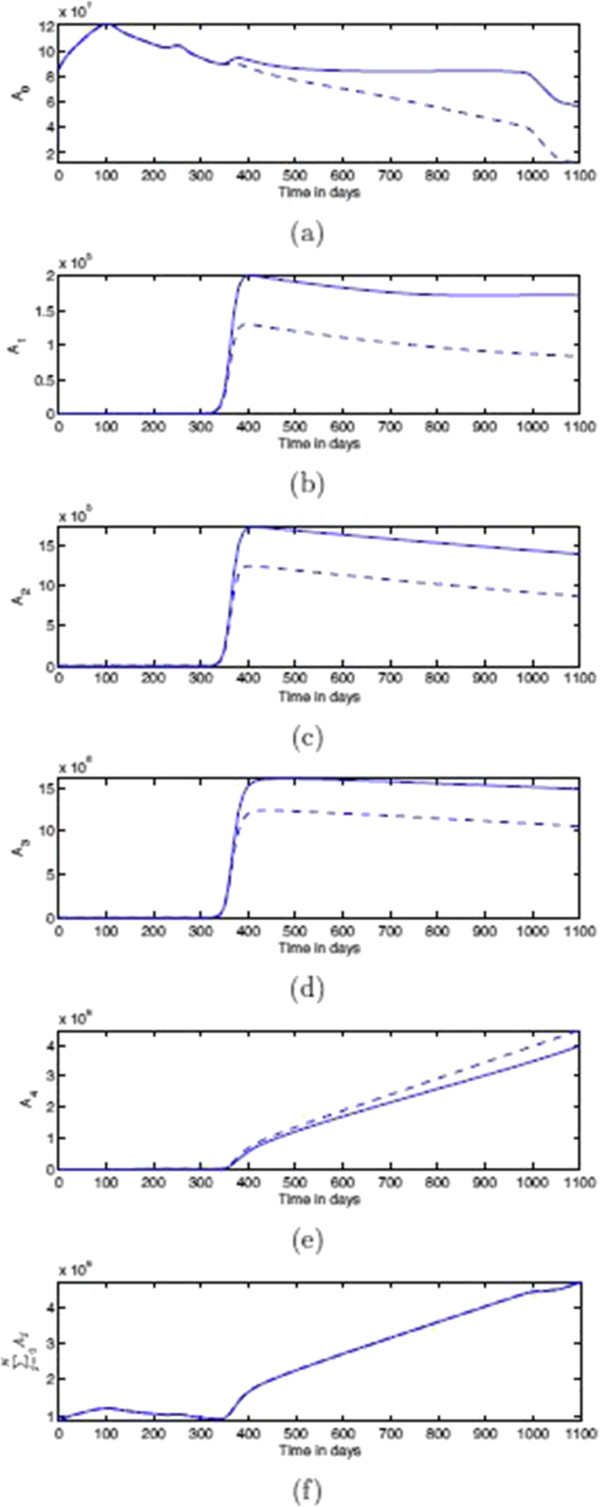
Effects of chemorepulsion on the total number of spatially distributed classes of tumour cells. Plots showing the effects of chemorepulsion on the total number of spatially distributed classes of tumour cells. Plots of the total number of cells Ai(t)=∫01Ti(x,t)dx. Panels: (a)A0, (b)A1, (c)A2, (d)A3, (e)A4, and (f)∑j=04Aj(t). Solid line with chemorepellent, dashed line without. Time is measured in days.